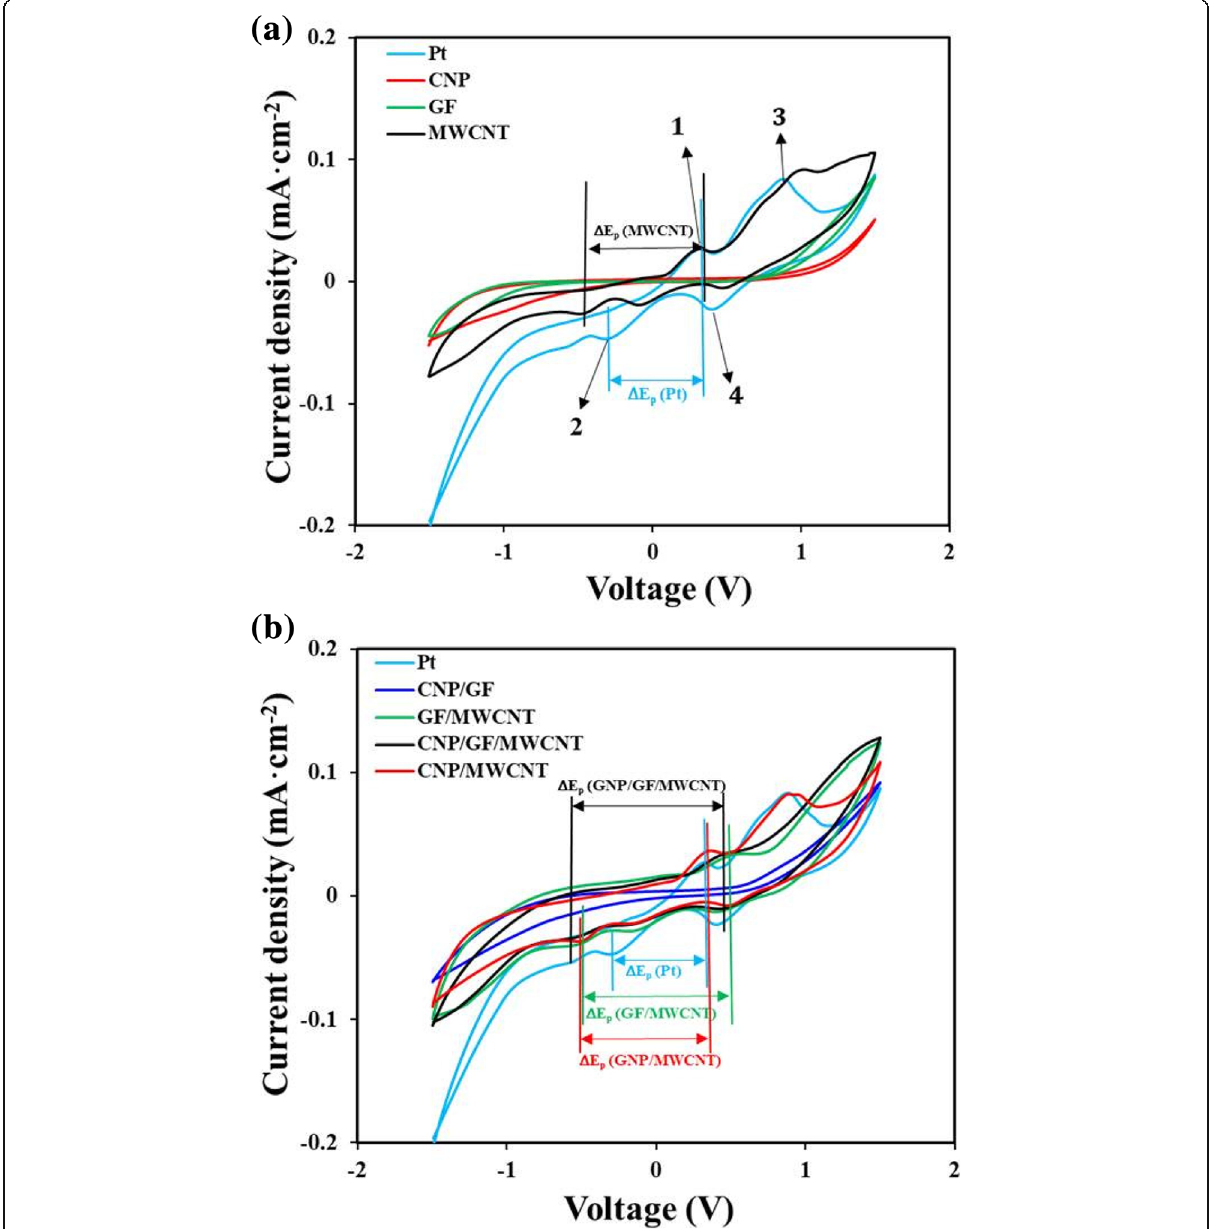
Fig. 5 a Cyclic voltammetry of Pt-, CNP-, MWCNT-, and GF-coated CEs. b Cyclic voltammetry of Pt- and carbon composites-coated CEs measured by scan rate of 50 mV s − 1 in 10 mM LiI, 1 mM I 2 acetonitrile, and 0.1 M LiClO 4 mixed electrolyte